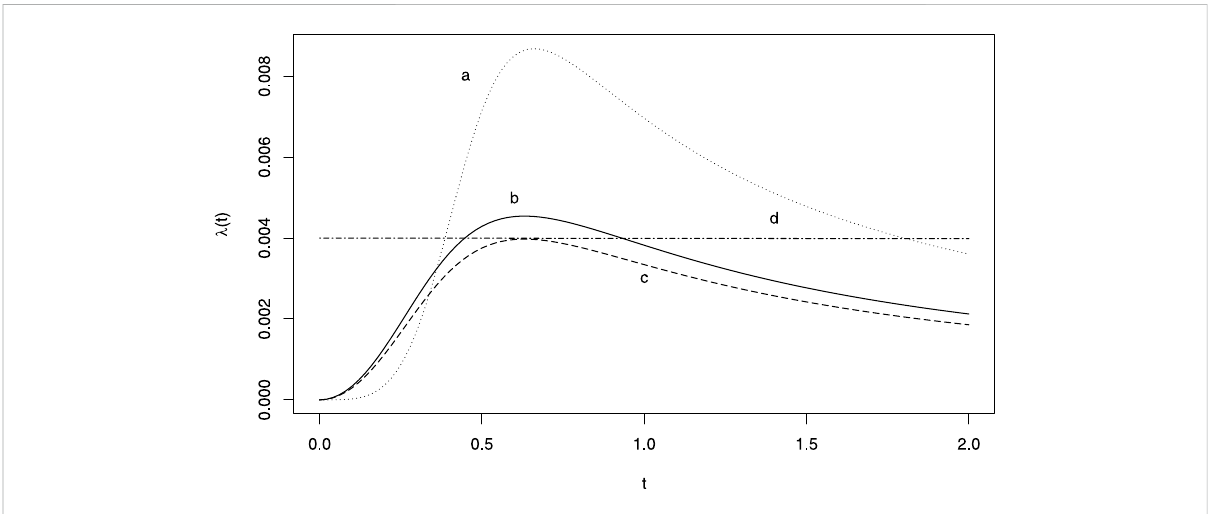
FIGURE 1 ExampleofhazardfunctionsobtainedfromageneralisedpowerWeibulldistribution. (A) ] =5, γ =700 θ =0.5; (B) ] =3, γ =700 θ =0.5; (C) ] =3, γ = 800 θ = 0.5; (D) ] = 1, γ = 1.5 θ =